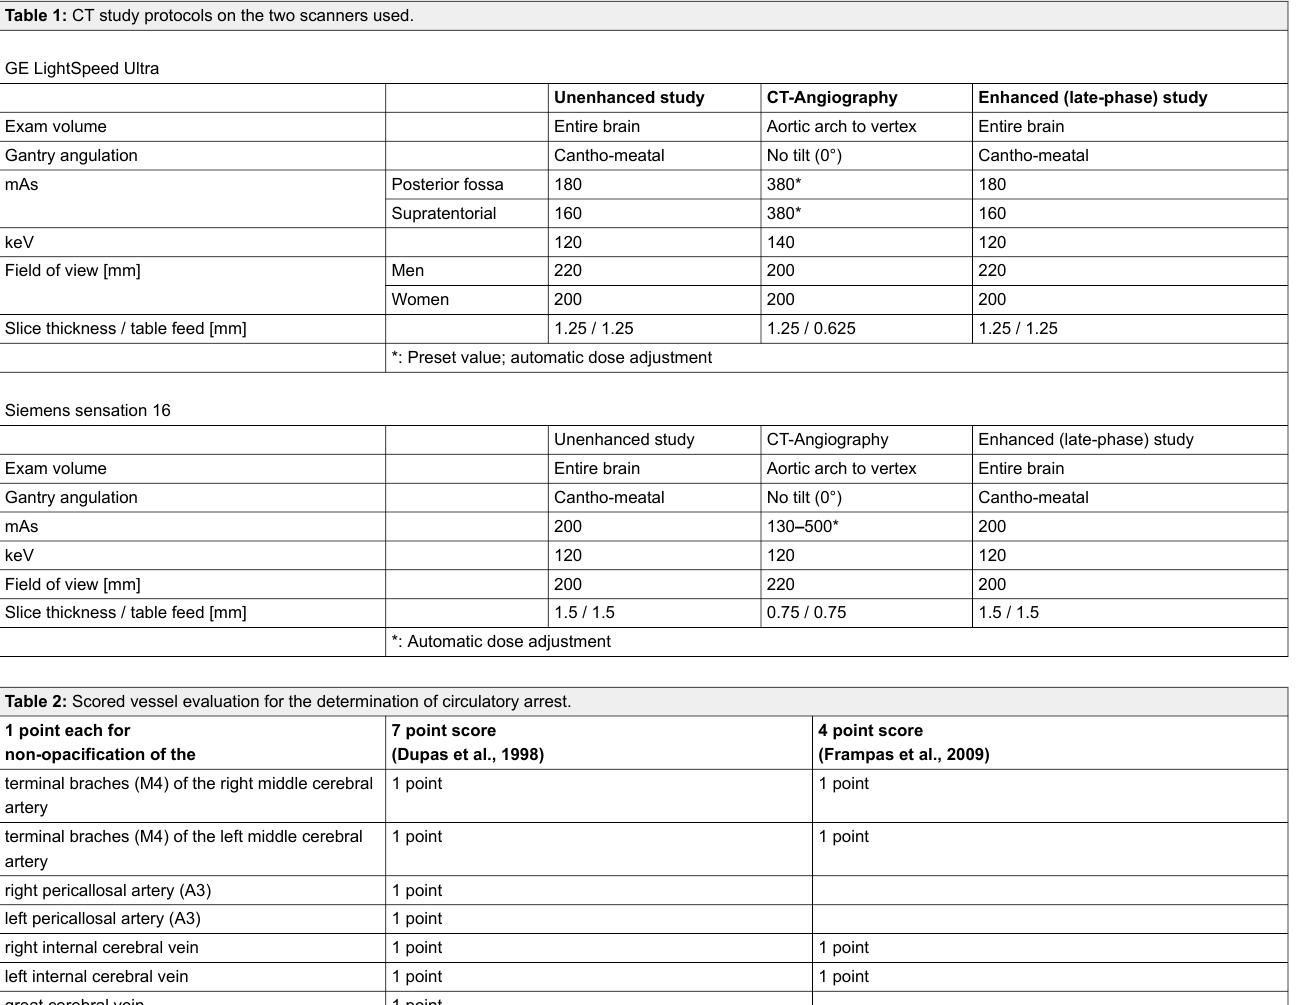
Table 1: CT study protocols on the two scanners used.